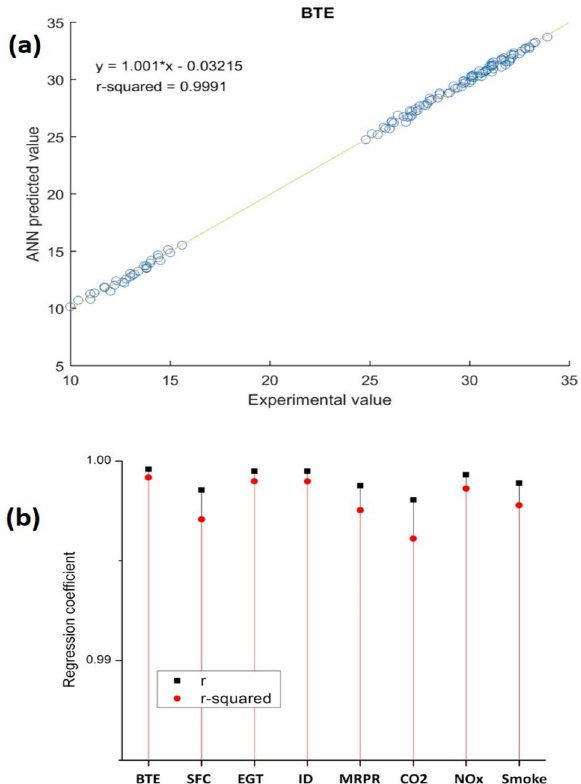
Figure 14. ( a,b ) The the prediction accuracy for all the responses.